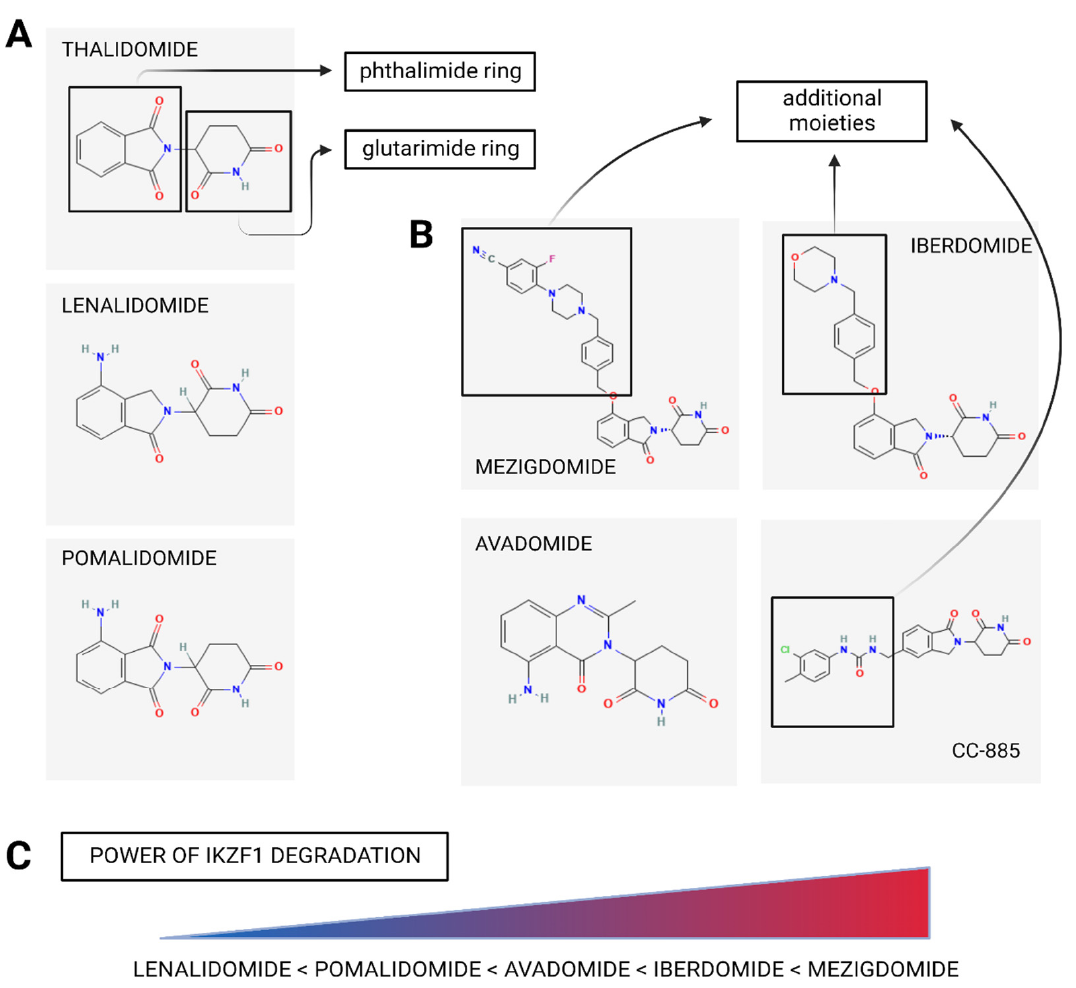
Figure 2. IMIDs/CELMoDs differences in chemical structure and power of IKZF1 degradation. Chemically, IMiDs ( A ) and CELMoDs ( B ) share glutarimide ring for binding to the tri-tryptophan pocket of CRBN, but the second structural region varies between each drug and determines the interaction with CRBN and neoubstrates. ( C ) The comparison of the IMiDs and CELMoDs potency in IKZF1 degradation.